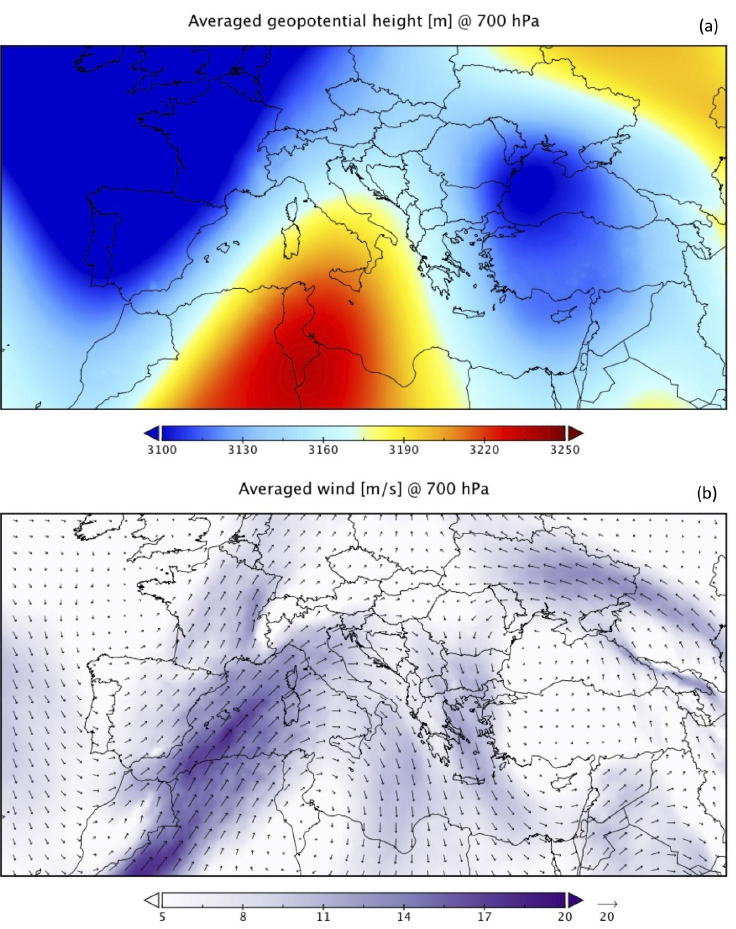
Figure 2. Full-period (17–24 June) averaged geopotential height (m) ( a ), and wind (vectors and speed; m s − 1 ) ( b ) at 700 hPa.